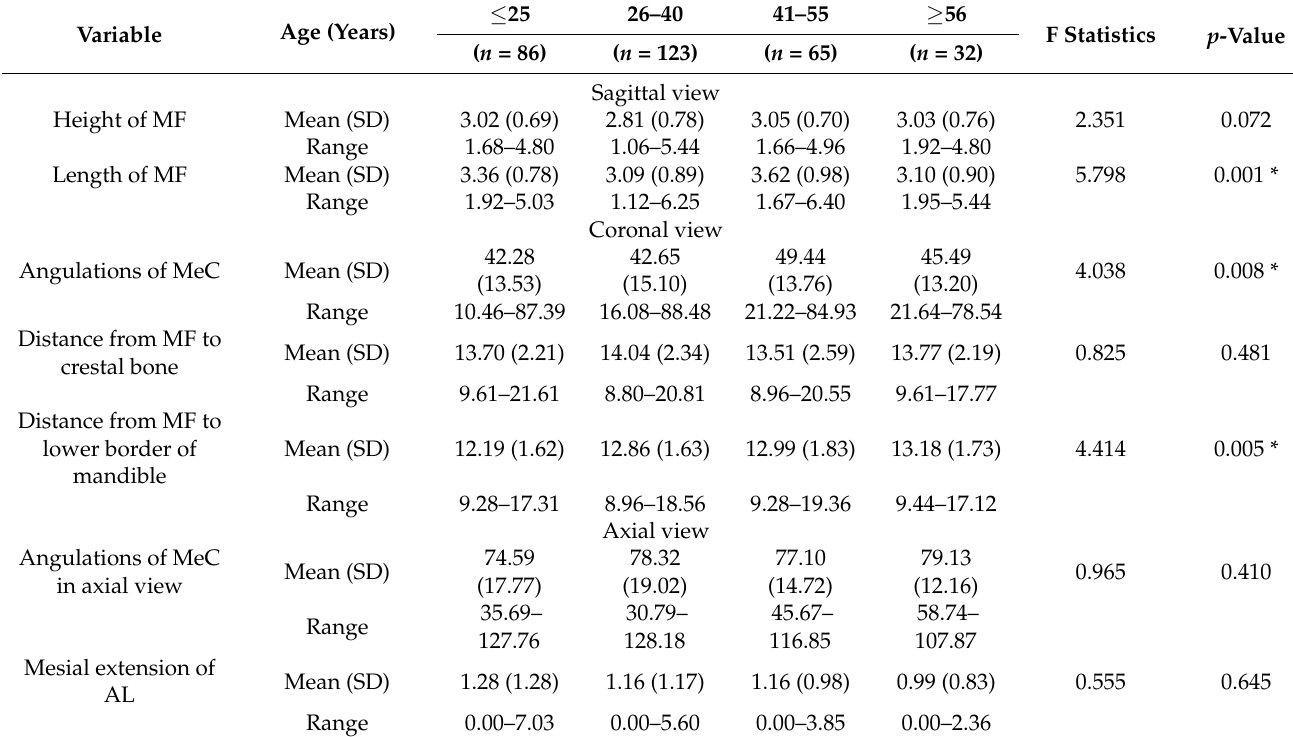
Table 4. Analysis of the dimensions (in mm) and distance (in mm) of the mental foramen, angulation of the mental canal, and extension of the anterior loop on different age groups ( n = 306